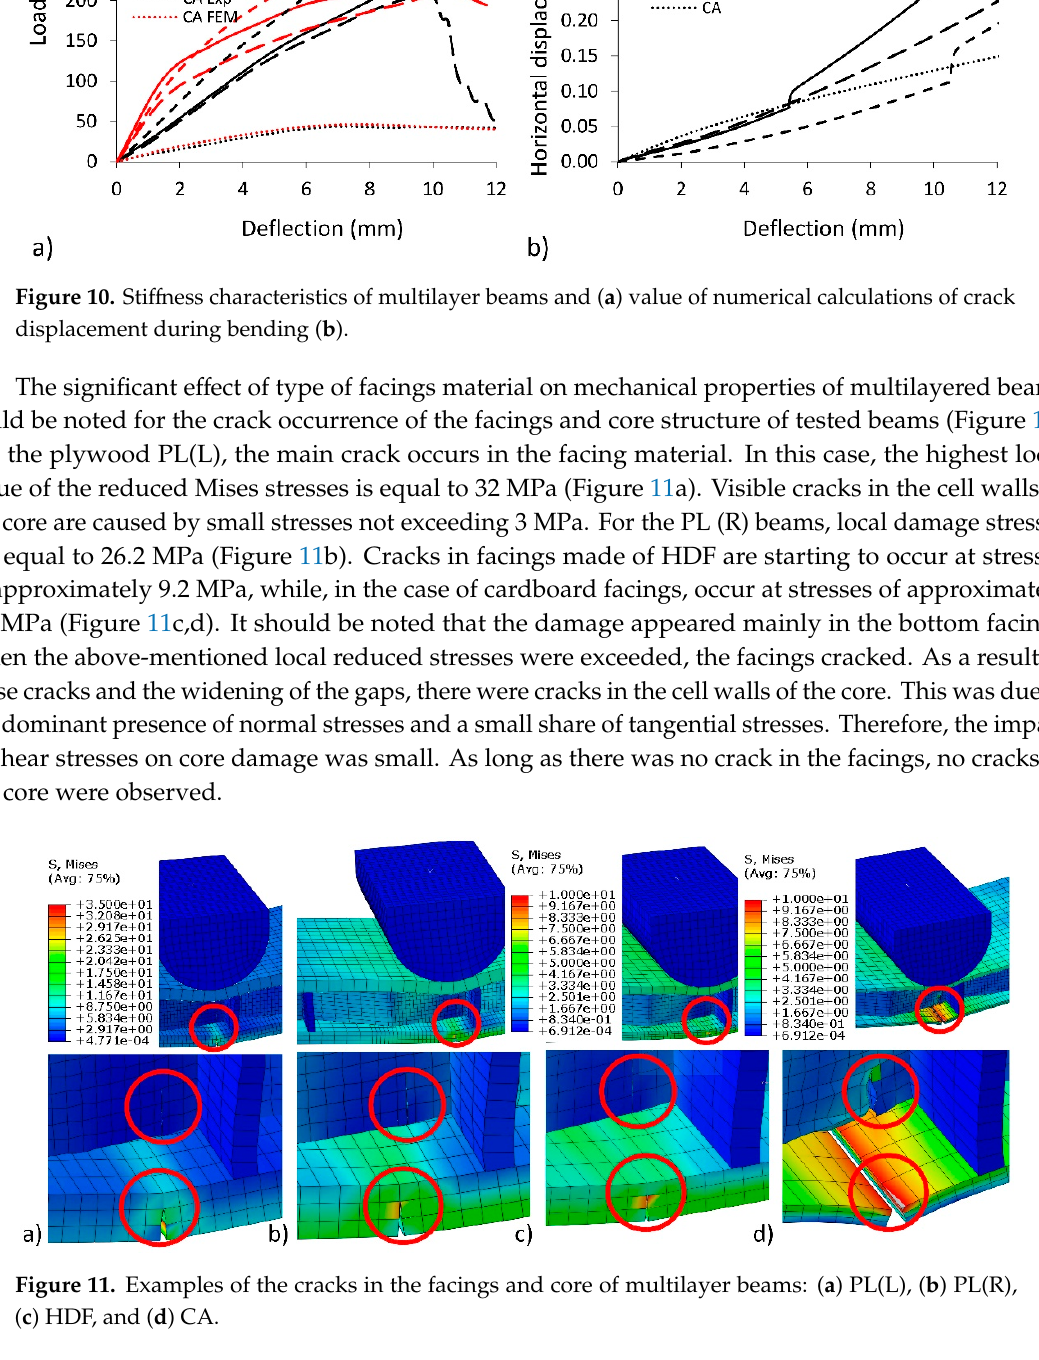
Figure 9. Examples of beams’ deflection: ( a ) PL(L), ( b ) PL(R), ( c ) HDF, and ( d ) CA.